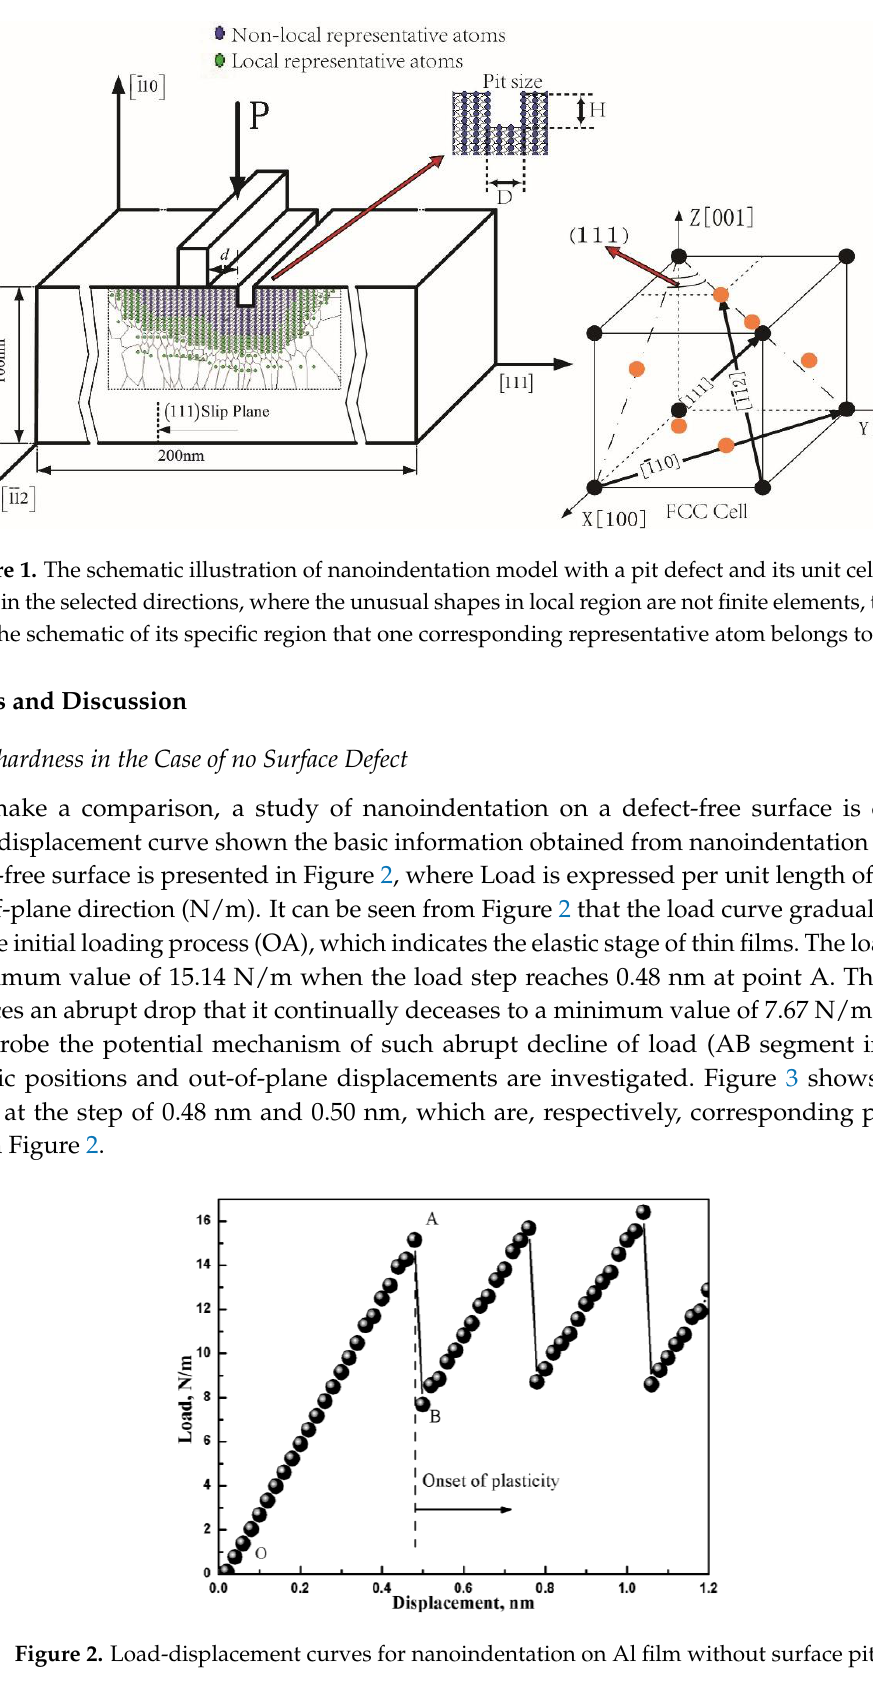
Figure 3. Snapshot of atoms under indenter and corresponding out-of-plane displacement plot, where UZ is atom displacement at out-of-plane. ( 1 ) point A in Figure 2 (dislocation nucleation); ( 2 ) point B in Figure 2 (dislocation emission). The conclusion can be drawn from Figure 3 that the load reaches the critical value for dislocation emission at point A, which indicates the beginning of plastic deformation stage. Then two Shockley partial dislocations are emitted at point B. The hardness is given by the equation [31]: max P H A 